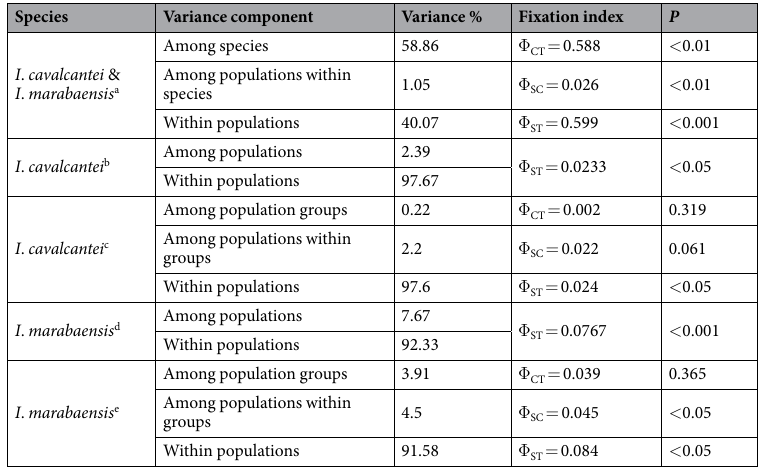
Table 3. AMOVA results, partitioning molecular variation in ITS2. a Canga groups (N1, N2, N3, N4), (N6, N7, N8, T, S11). b One group of Canga populations (N1, N2, N3, N4). c Canga populations groups (N1, N4), (N2, N3). d One group of Canga populations (N6, N7, N8, T, S11). e Canga population groups (N6, N7), (N8, T),